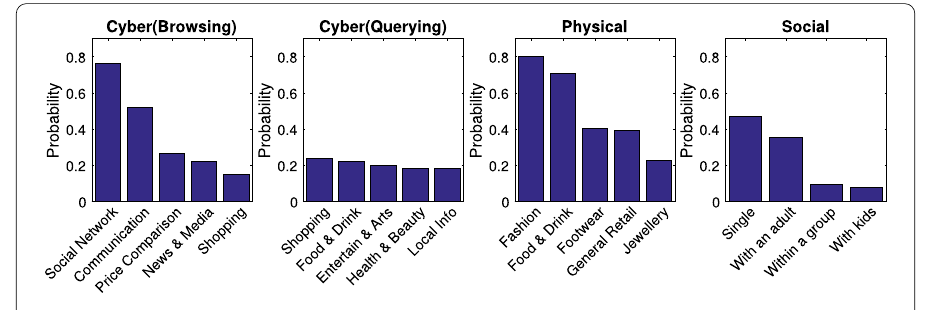
Figure 1 (a) the distribution of the top 5 popular Web categories that users browsed; (b) the distribution of the top 5 popular Web categories that users queried using search engines; (c) the distribution of the top 5 popular shop categories that users physically